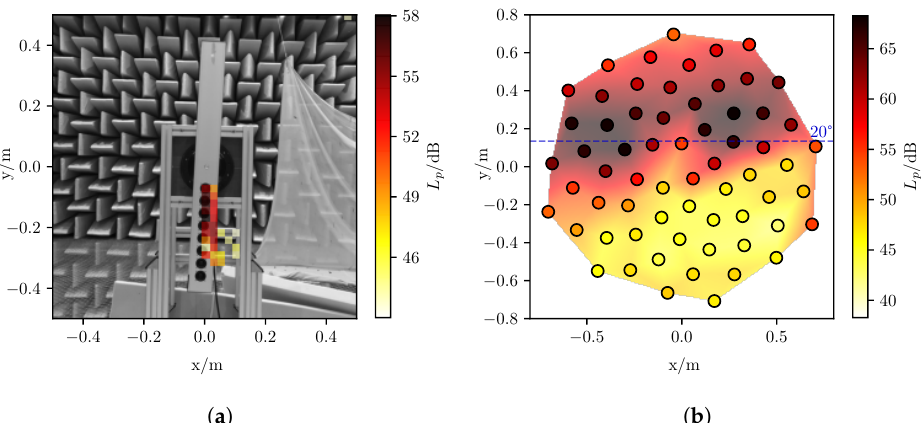
Figure 7. Test case 4 with a rotating speaker array and 20 ◦ positive direction steering: ( a ) source distribution; ( b ) source directivity in the direction of the microphones at the 5 kHz octave band. The blue dotted line indicates the theoretical maximum at 20 ◦ .